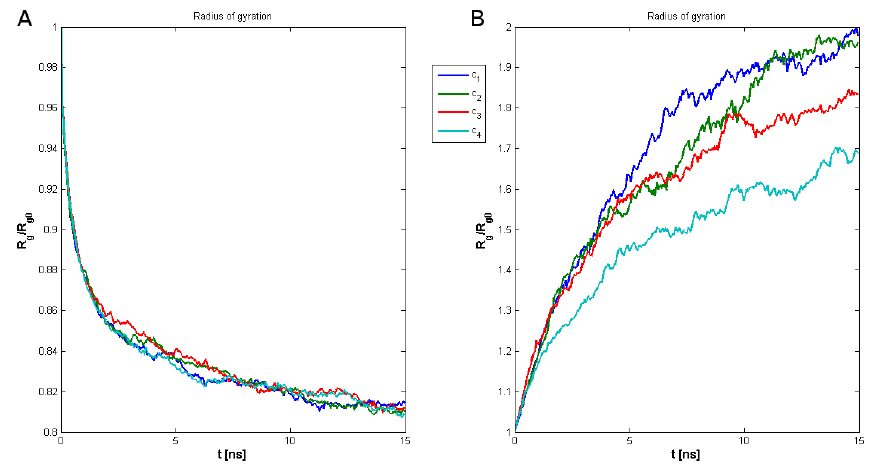
Figure 8. Radius of gyration of an average HA chain: ( A ) inter-molecular networks are depicted; and ( B ) intra-molecular